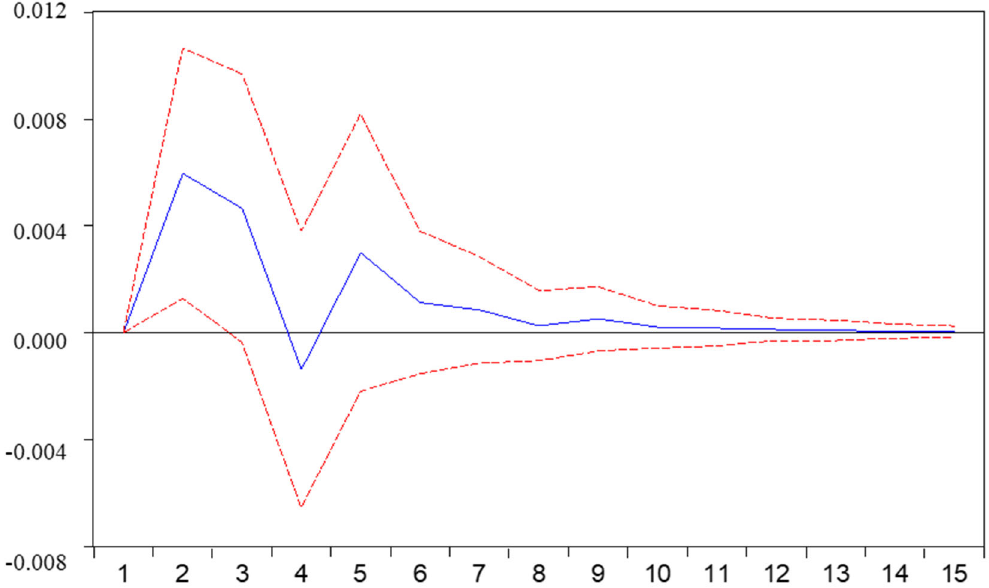
Figure 6. Response of realized volatility to Bitcoin attention. The X-axis refers to the time for response while the Y-axis represents the magnitude of response. The blue line refers to the value while the red line refers to the confidence interval. Table 16. Nonlinear relationship between realized volatility and Bitcoin